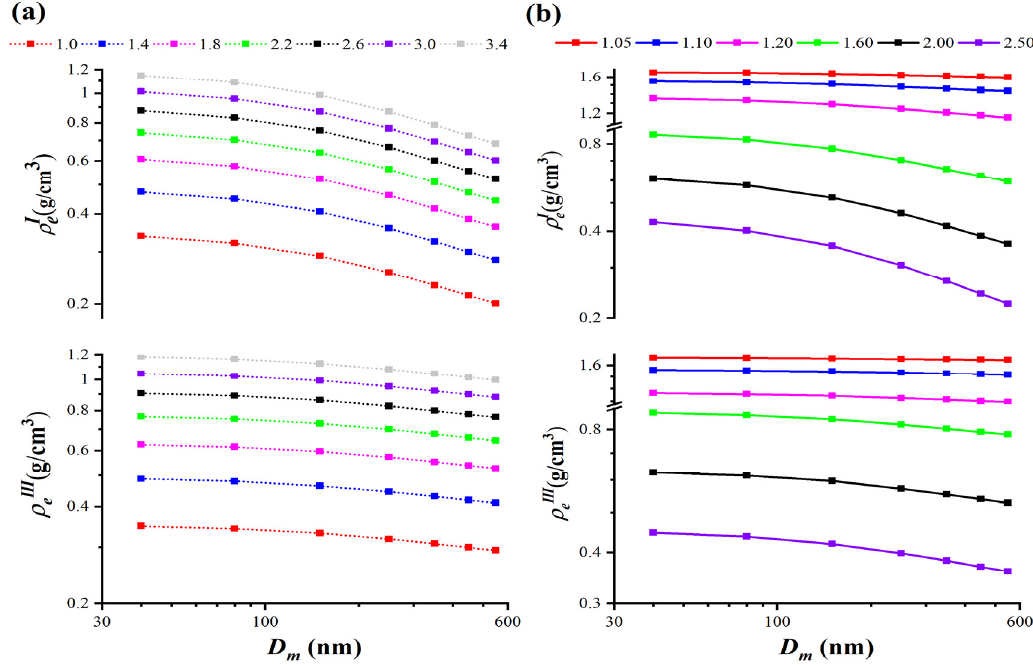
Figure 1. ( a ) The size variations of ρ eI and ρ eIII for the Y particles. The change in color from red to grey represents the increase in density from 1.0 to 3.4 g/cm 3 ; ( b ) The size variations of ρ eI and ρ eIII for the Z particles. The change in color from red to purple represents the increase in dynamic shape factor from 1.05 to 2.50.